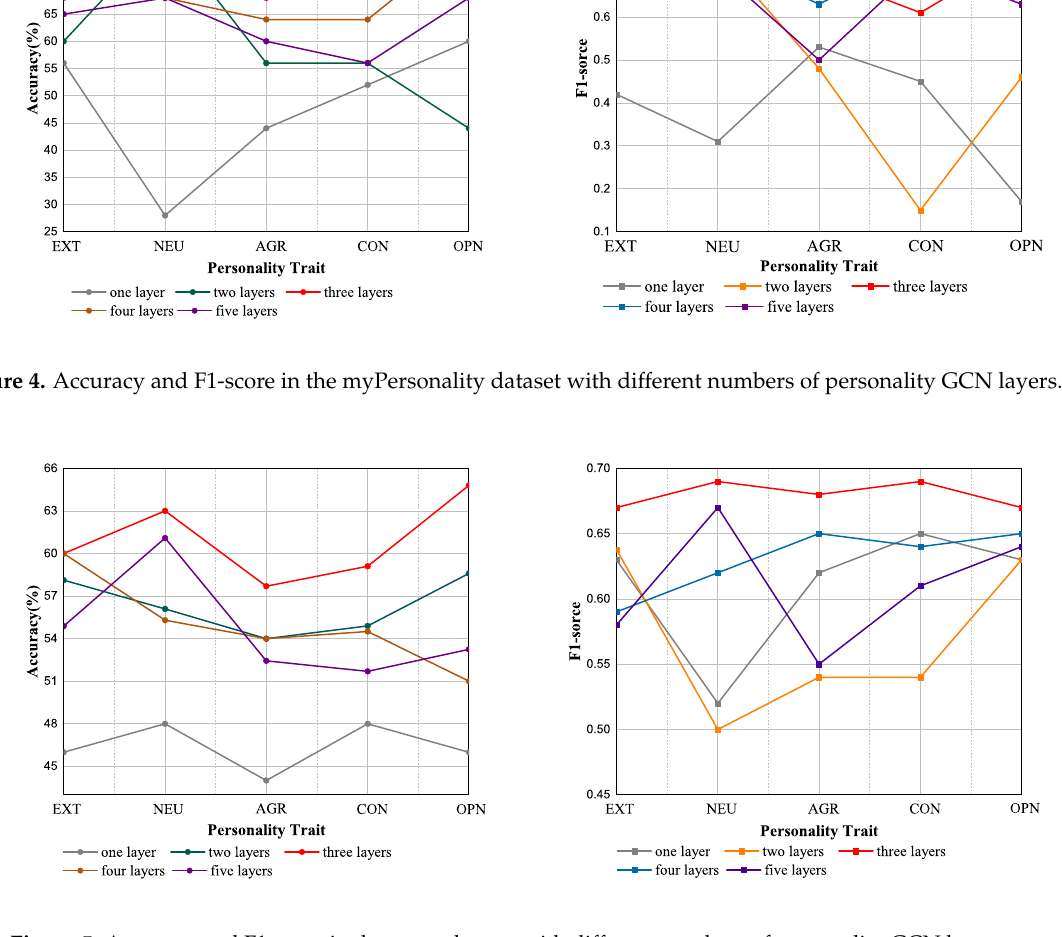
Figure 5. Accuracy and F1-score in the essay dataset with different numbers of personality GCN